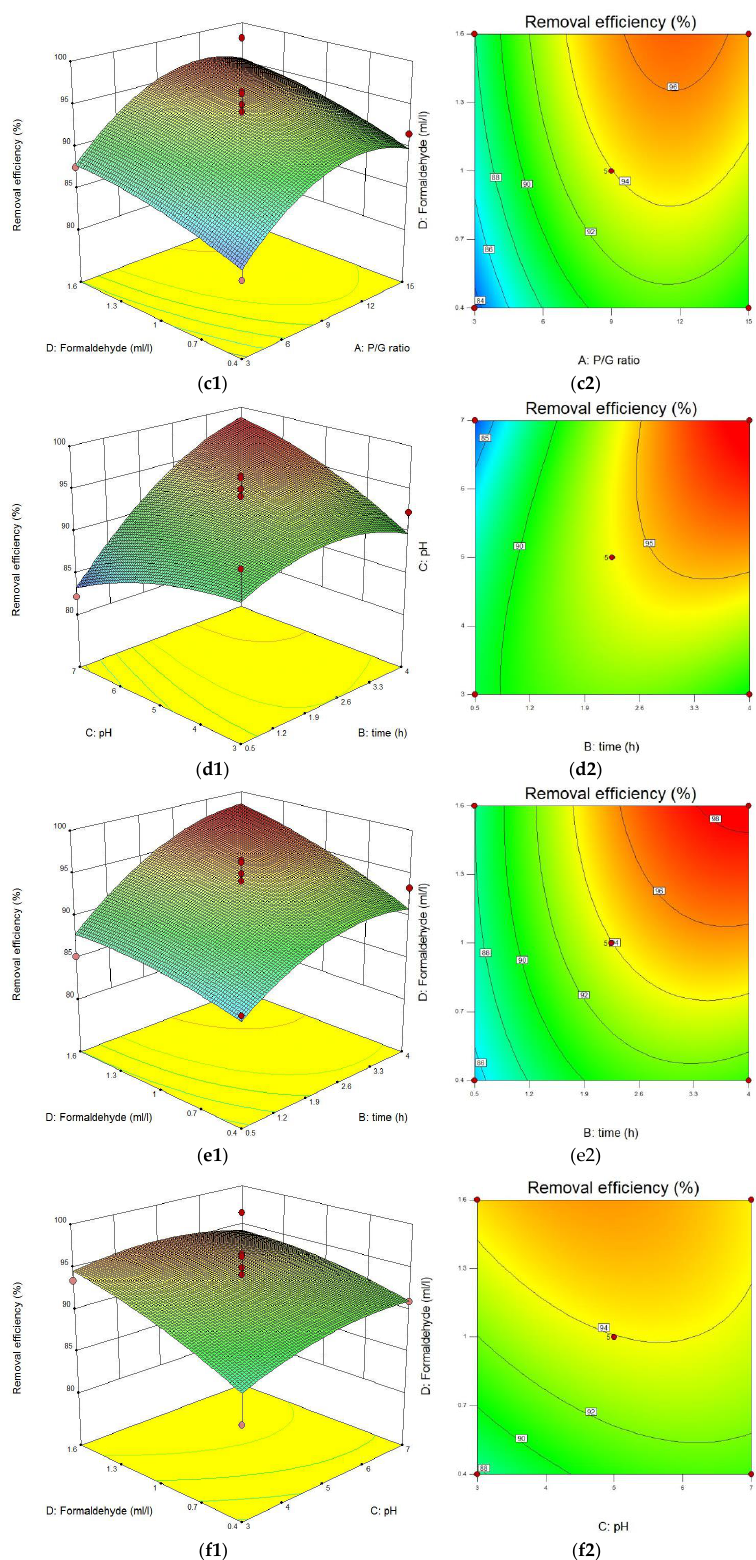
Figure 3. Contour map and response surface curve. ( a1 ) Response surfaces of A and B and ( a2 ) contour plots of A and B; ( b1 ) response surfaces of A and C and ( b2 ) contour plots of A and C; ( c1 ) response surfaces of A and D and ( c2 ) contour plots of A and D; ( d1 ) response surfaces of C and B ( d2 ) contour plots of C and B; ( e1 ) response surfaces of B and D and ( e2 ) contour plots of B and D; ( f1 ) response surfaces of C and D and ( f2 ) contour plots of C and D.